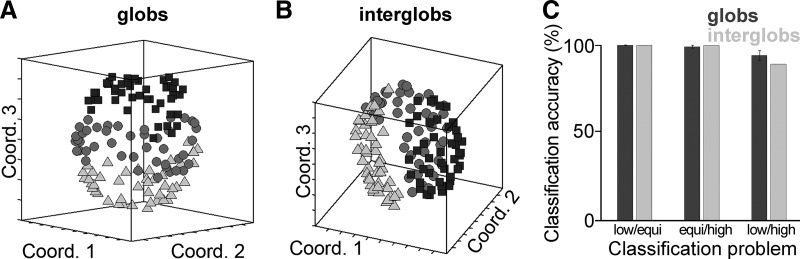
Luminance clustering within neural color space (A, B) and luminance decoding (C). Both the glob and interglob populations segregate stimuli by luminance. A, B, Three-dimensional MDS embedding for the glob (A) and interglob (B) populations. Squares indicate low-luminance stimuli, circles indicate equiluminant stimuli, and triangles indicate high-luminance stimuli. C, Luminance information is accessible to readout by a linear classifier invariant to changes in hue for both populations, showing that these populations carry information about stimulus luminance as well as hue. Mean classification accuracies across decoding runs were high (>89%) for distinguishing between all luminance class pairs, for both populations (all p < 0.005, permutation test). Error bars indicate the SD of the mean across 200 subsampling runs.